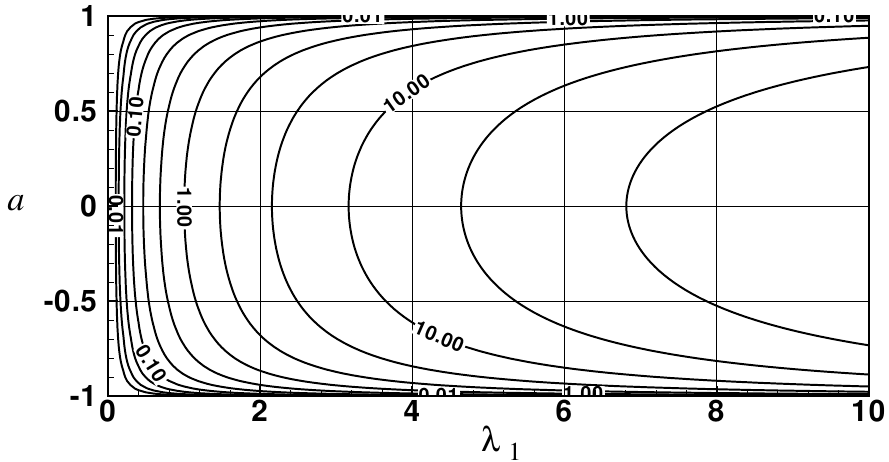
(cid:0) [ (cid:1) 1 − a 2 ] λ 2 as a function of a and λ 1 1